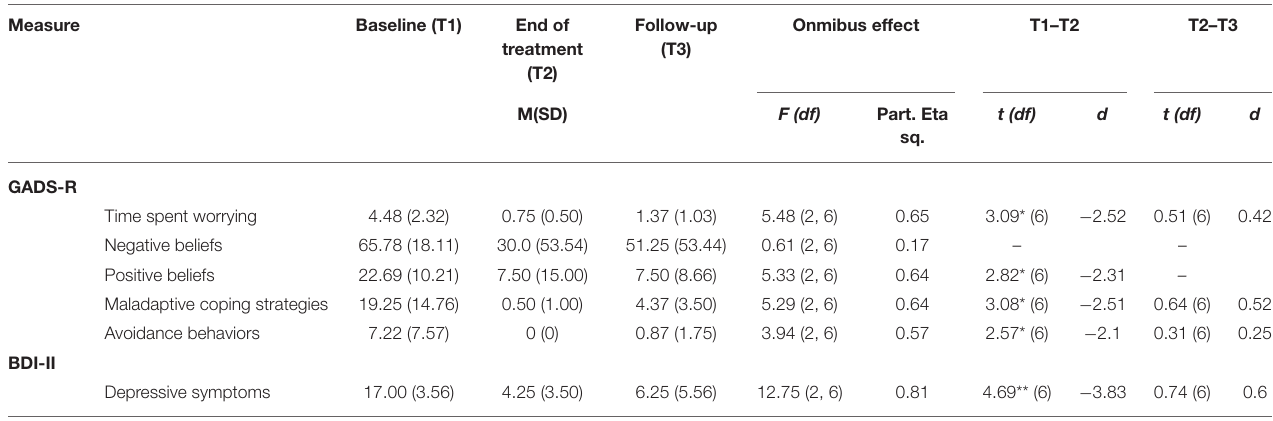
TABLE 3 | Repeated measures ANOVA and protected t -tests testing change in secondary outcome variables (anxiety symptoms and metacognitions in the GADS-R, and depressive symptoms in the BDI-II).